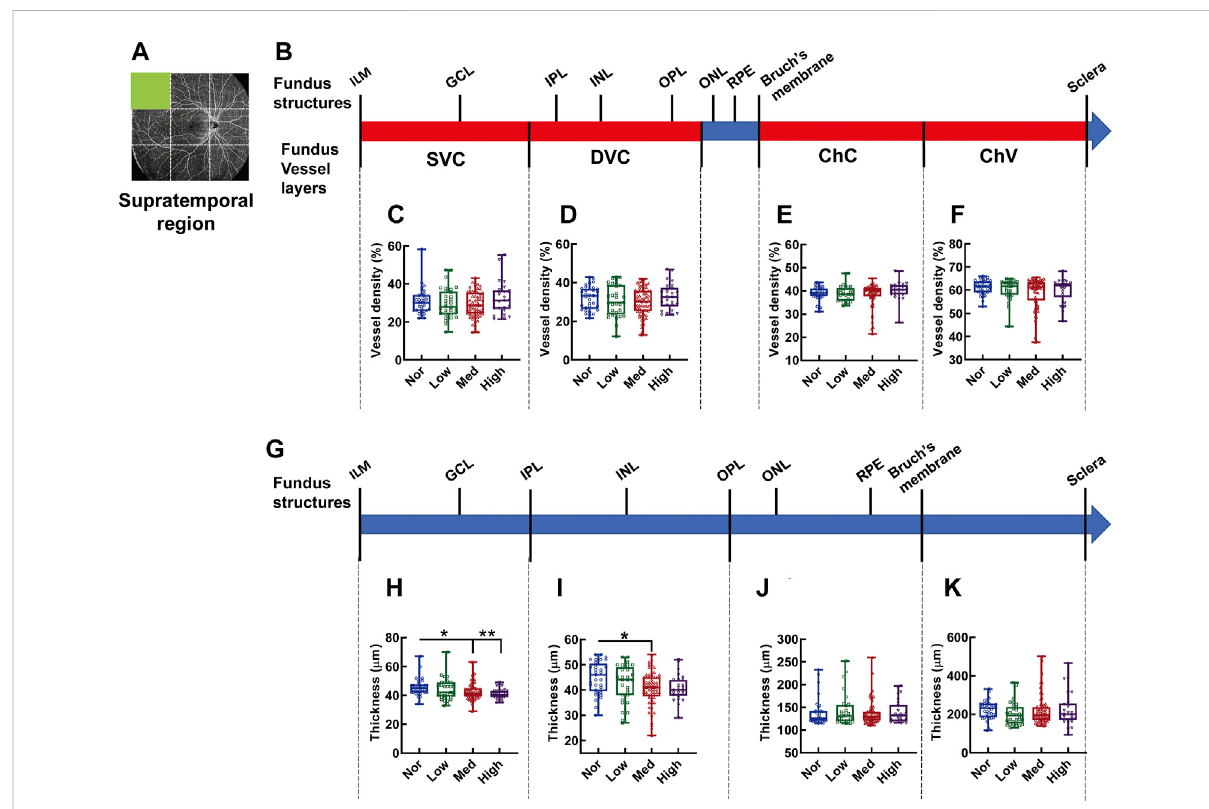
FIGURE 3 Vessellayerdensitiesandstructurethicknessesatthesupratemporalregionofthefundus.Positionofthesupratemporalregionofthefundusis illustratedin (A) .Schematicillustrationofvessellayersinthefundusisshownin (B) .Vesseldensitiesofsuper fi cialvascularcomplex (C) ,deepvascular complex (D) , choriocapillary (E) , and choroidal vessel (F) layers were quanti fi ed and compared. Schematic illustration of segments in the fundus is shown in (G) . Thicknesses of the segments from IML to IPL (H) , from IPL to OPL (I) , from OPL to Bruch ’ s membrane (J) , and from Bruch ’ s membrane to the sclera (K) are quanti fi ed and compared. * p < 0.05, ** p < 0.01. SVC, super fi cial vascular complex; DVC, deep vascular complex; ChC, choriocapillary layer; ChV, choroidal vessel layer; NOR, normal group; Low, low-myopia group; Med, medium-myopia group; High, high myopia group; IML, inner limiting membrane; IPL, inner plexiform layer; and OPL, outer plexiform